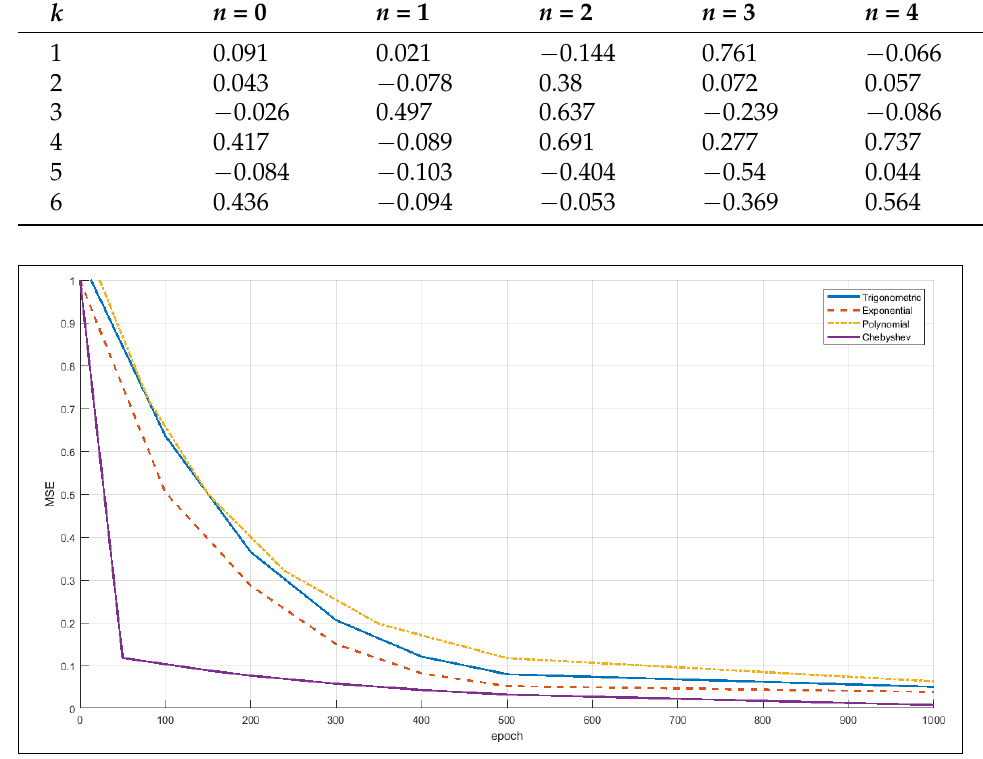
Figure 7. A comparison of convergence properties during model